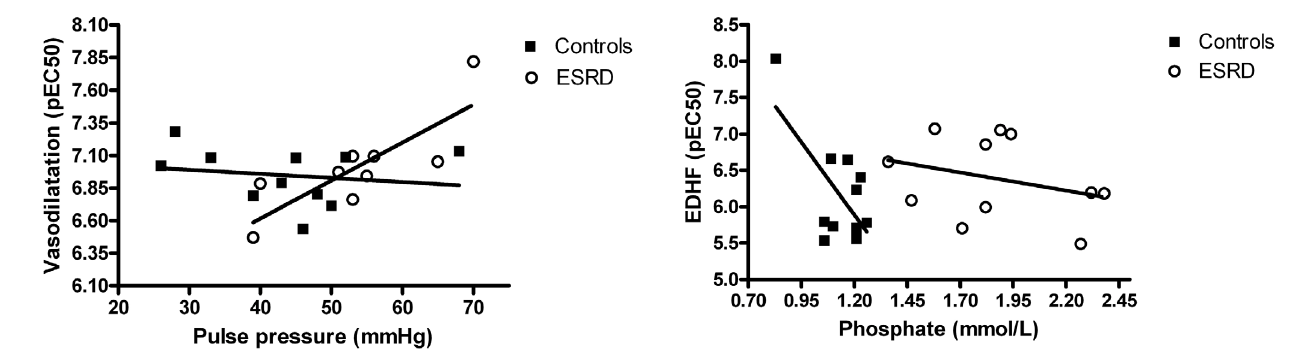
Figure 5. Association between pulse pressure and vasodilata- tion (pEC 50 ) in controls (r= 2 0.17; p=0.31) and ESRD (r=0.81; p , 0.01), Pearson one-tailed correlation.